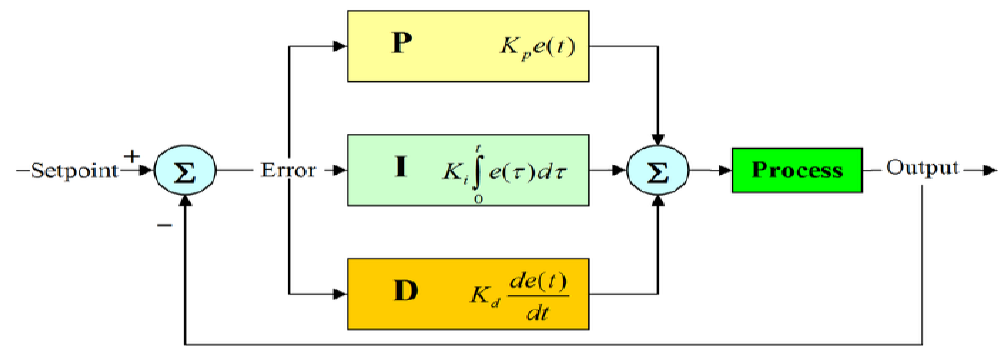
Figure 3. General PID controller.